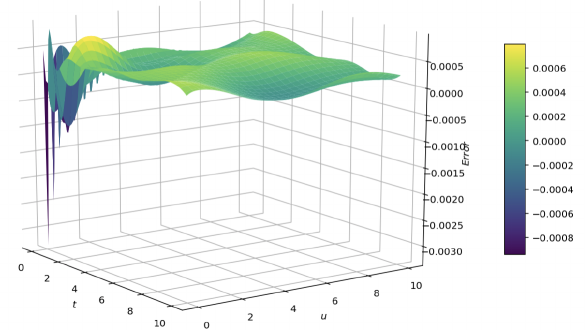
Figure 6. The error between DNN approximation for parameter 2 and the explicit